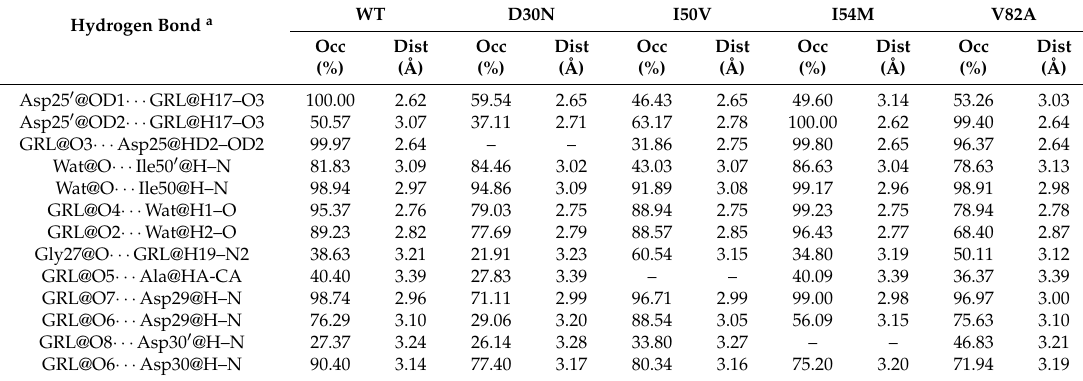
Table 3. Main hydrogen bonds involved in the GRL-0519 binding